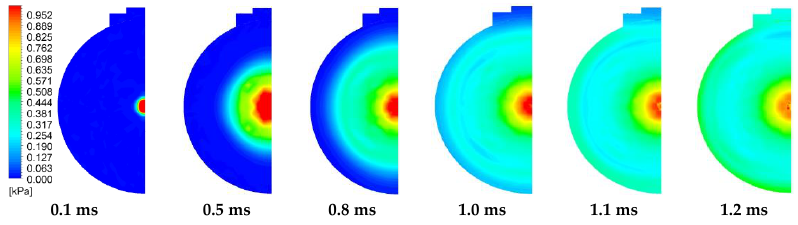
Figure 15. Pressure distribution of the cross section in the container.